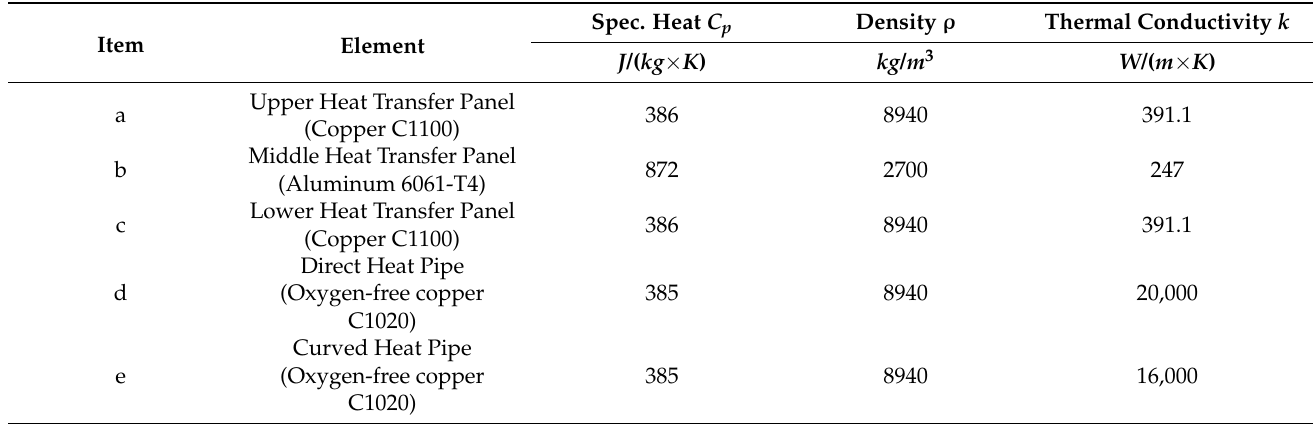
Table 1. Material and Physical